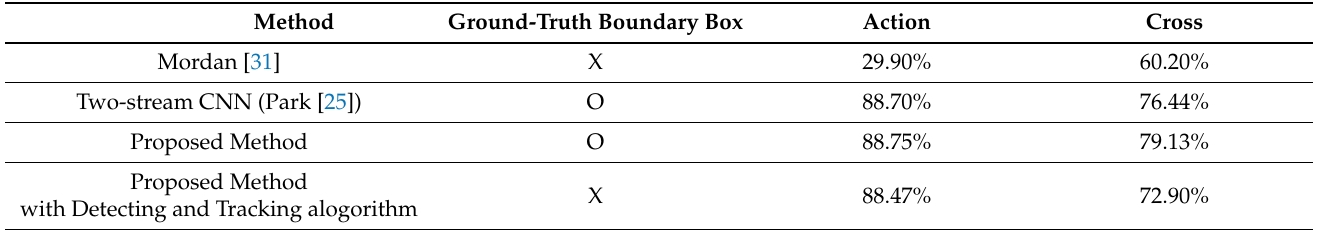
Table 9. Comparison of state-of-the-art in multitask learning algorithm with the JAAD testing dataset.